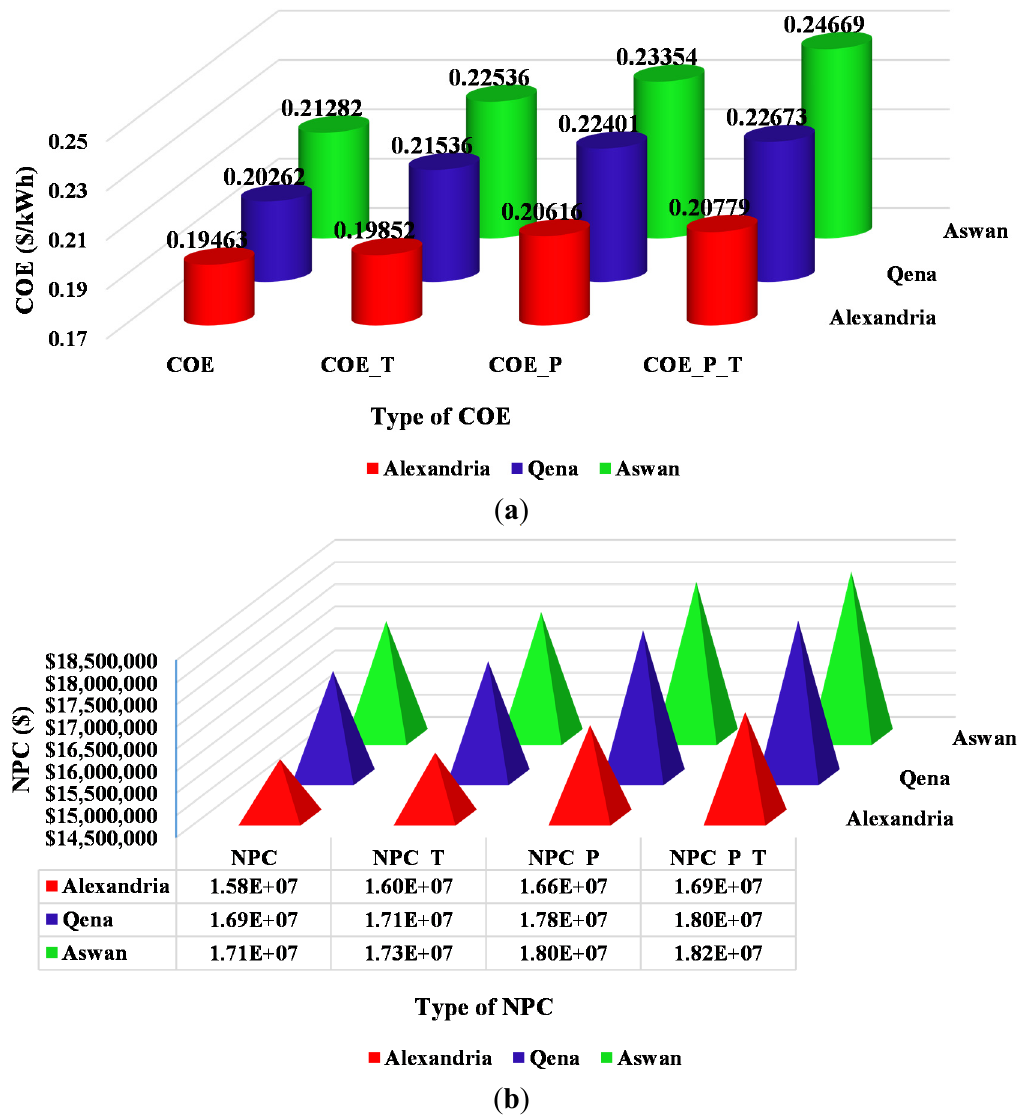
Figure 10. ( a ) The different COE of wind/diesel/battery system in Alexandria, Qena and Aswan; ( b ) The different NPC of wind/diesel/battery system in Alexandria, Qena and